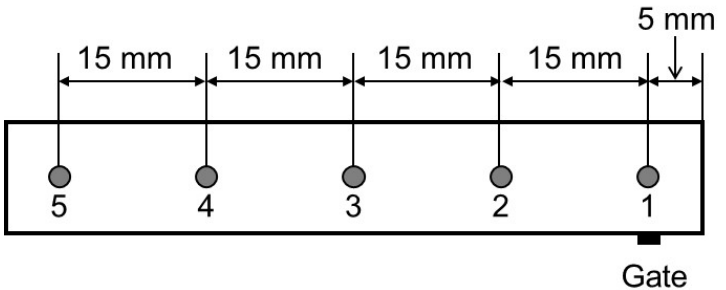
Figure 1. Measurement points used to obtain the attenuated total reflectance Fourier-transform infrared (ATR-IR) spectra of an injection-molded bar.